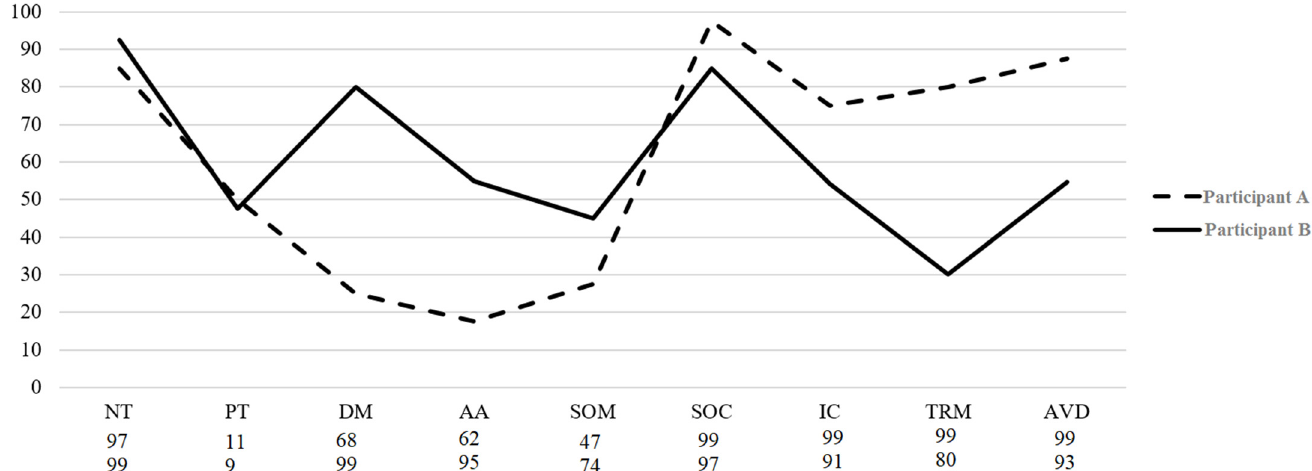
Figure 1. Profiles of two participants according to their scores in each MEDI. Legend. The Y-axis represents the percentage of the score obtained in each dimension over the maximum score. Scores under each dimension represent the participant’s percentile. NT: Neurotic temperament; PT: Positive temperament; DM: Depressed mood; AA: Automatic arousal; SOM: Somatic anxiety; SOC: Social anxiety; IC: Intrusive cognitions; TRM: Traumatic re-experiencing; AVD: avoidance.